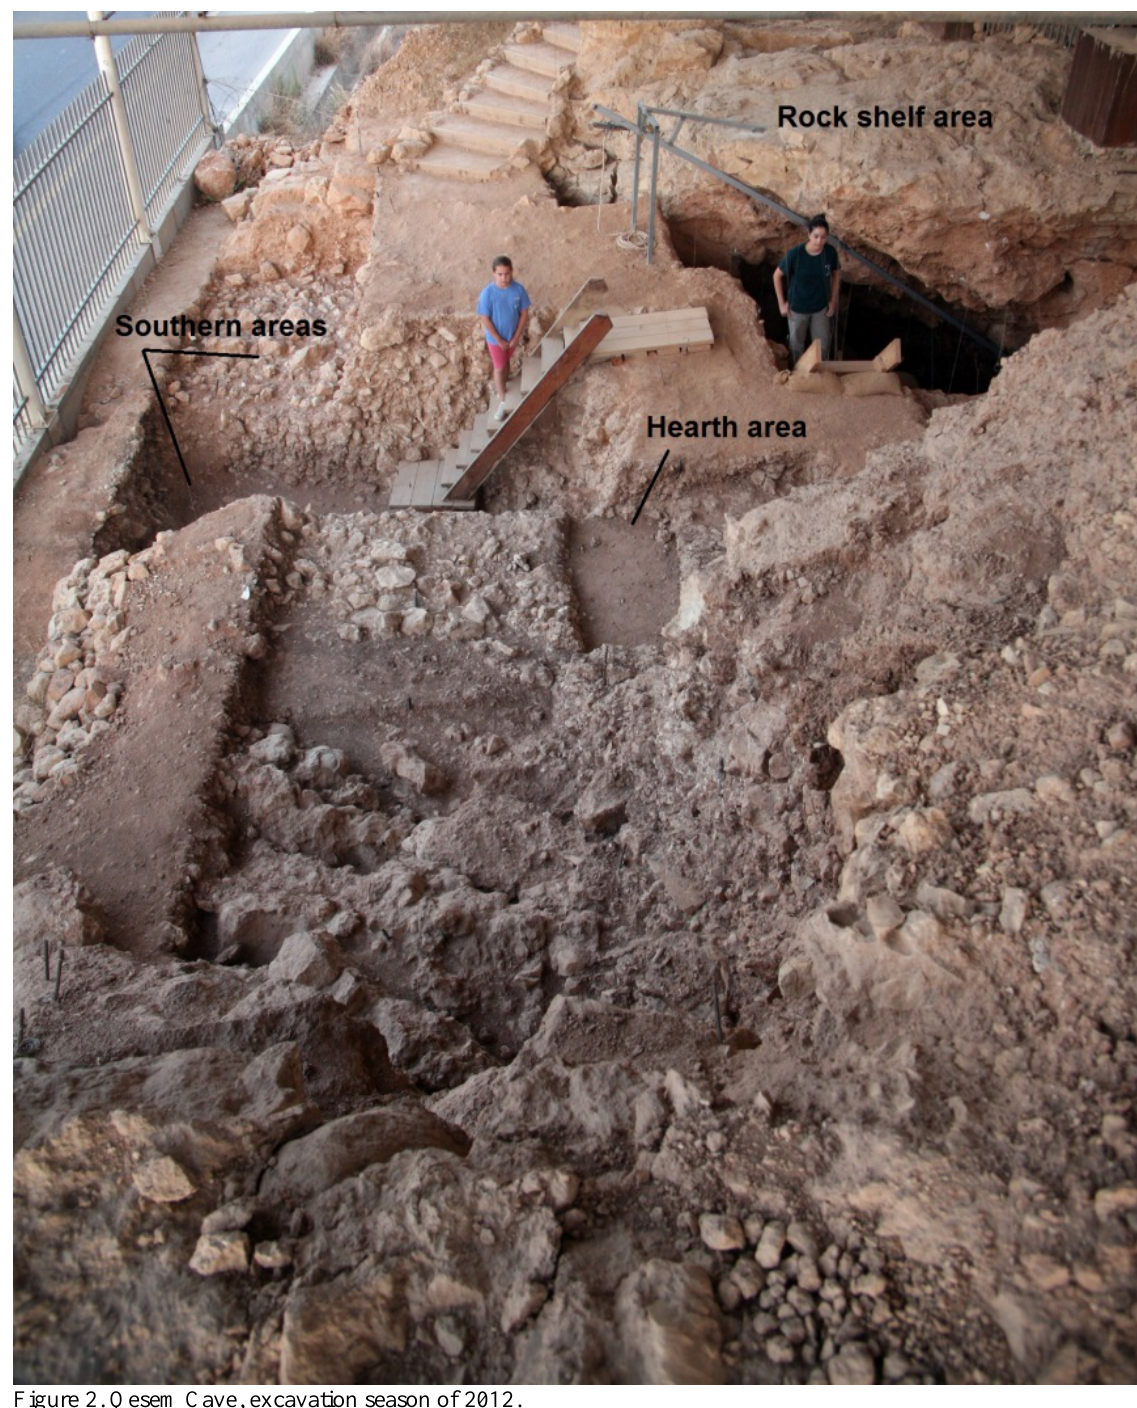
Figure 2. Qesem Cave, excavation season of